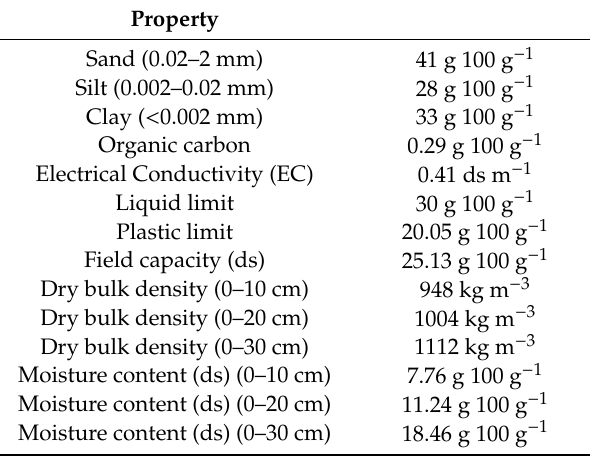
Table 1. Analysis of soil at the experiment site.